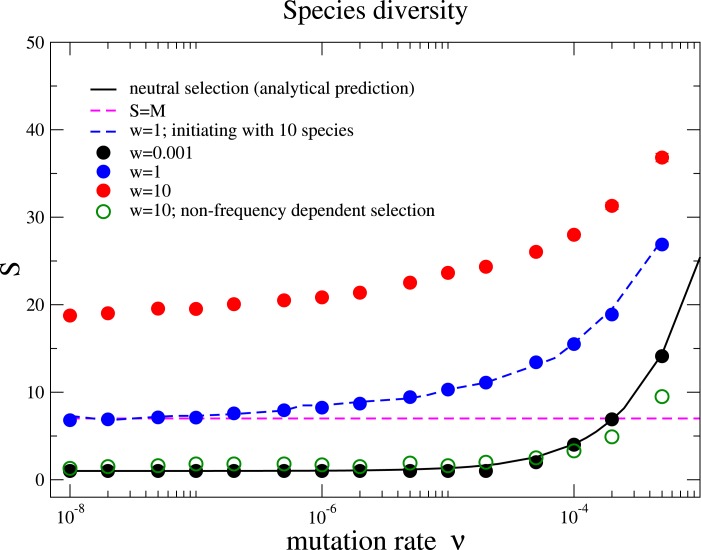
Species diversity S versus mutation rate ν under different selection intensities.The solid line is the theoretical prediction of the neutral theory given by Eq. (4) in the main text, which fits well with our simulation results under near neutral selection w = 0.001. The species diversity increases when the selection intensity becomes stronger (w = 1 and w = 10). This holds under different initial conditions with a homogenous community or a community with multiple species (w = 1, blue dots for 1 species and blue dashed line for10 species with random half-saturation constants). In a large parameter range, the average number of species can be above the total number of limiting resources in the community (the pinked dashed line for S = M). In addition, the species diversity is much lower if interactions between different species are frequency independent (comparing the green unfilled points with the red points under w = 10). The Parameter sets: N = 2, 000, M = 7, Mcons = 5, and RMax = 300. (The results are averaged over 106 generations after the community has evolved for 108 generations.)